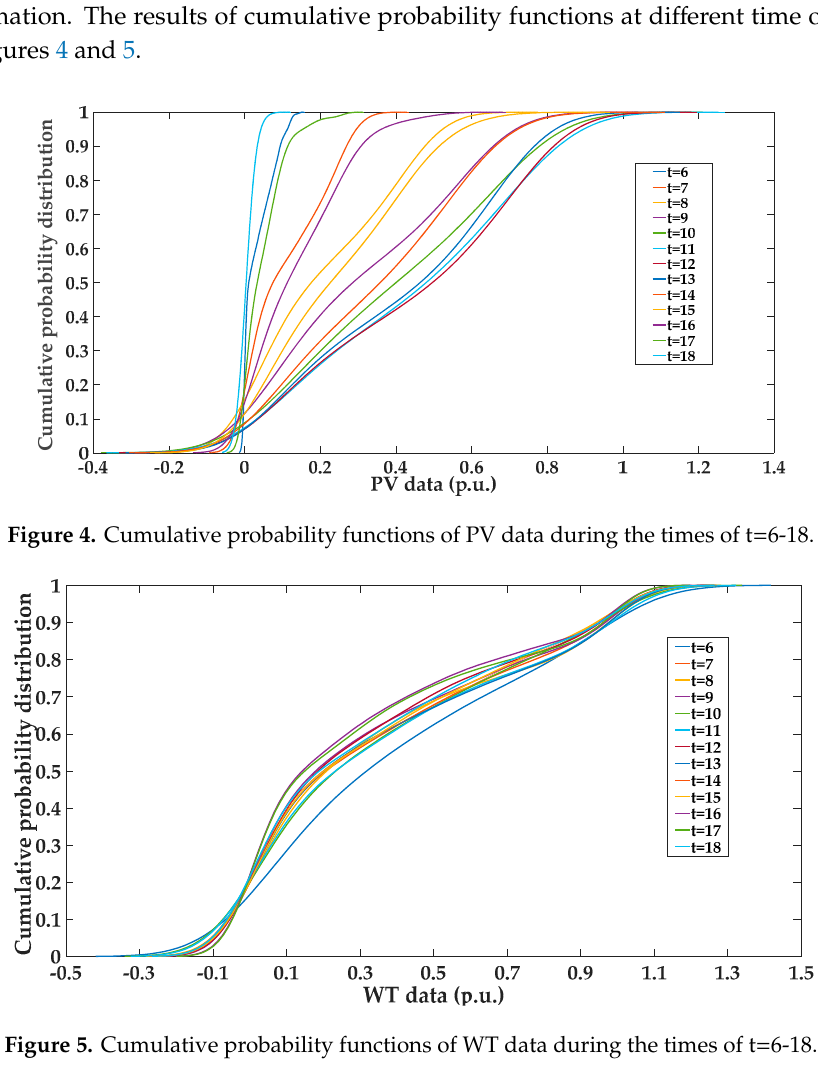
Figure 3. Calculation process of the proposed method.